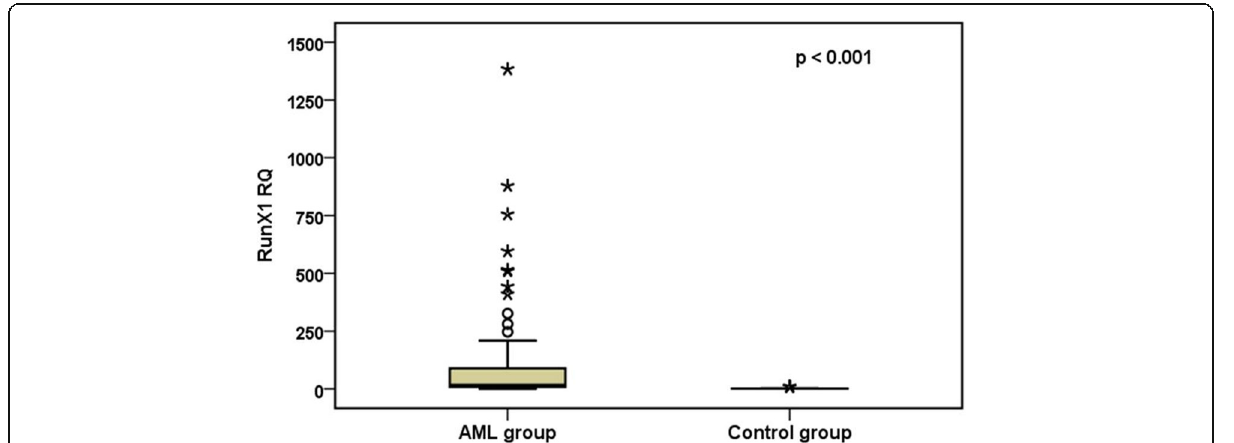
Fig. 1 Comparison between relative RUNX1 gene expression in AML cases and control